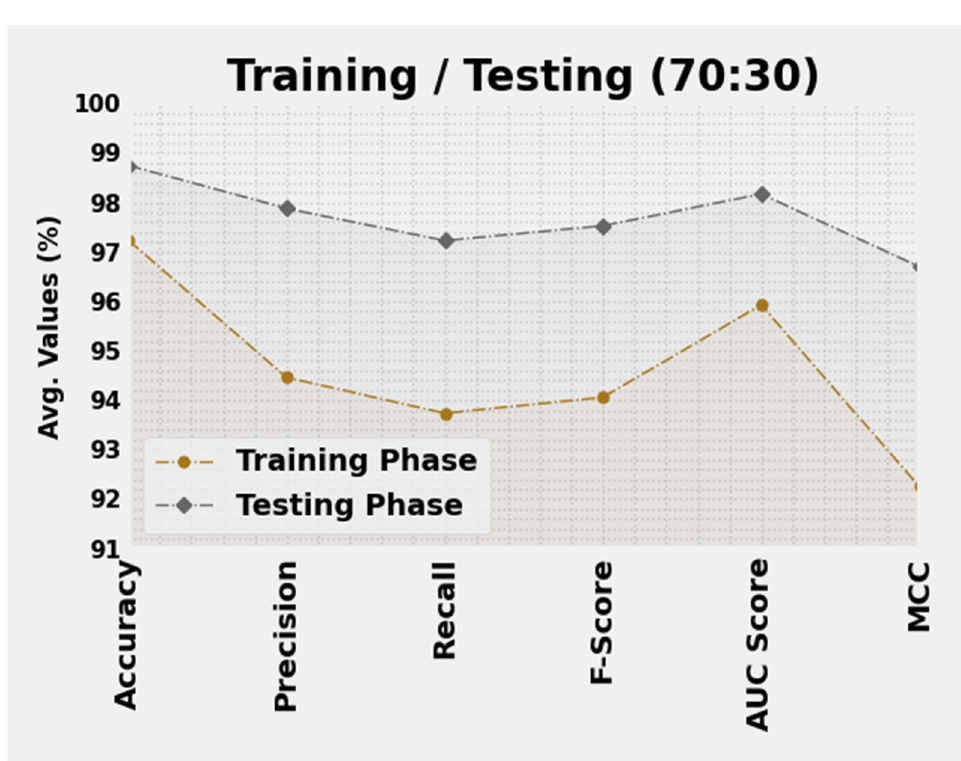
Figure 10. Average outcome of TSADL-LULCCD approach on 70:30 of TR/TS databases.